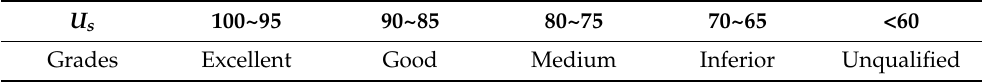
Table 3. Uniformity